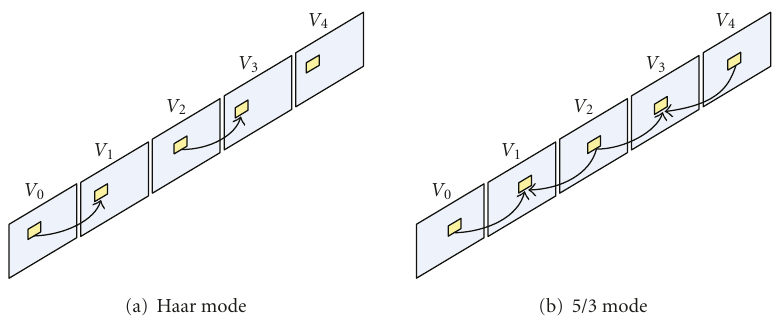
Figure 4: Illustration of the reference image views in DCWL Haar and 5/3 types.